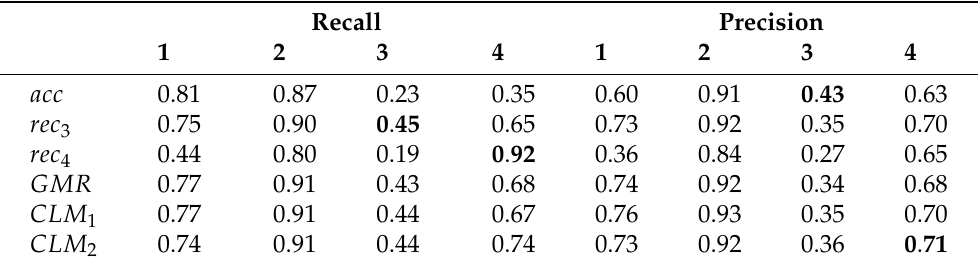
Table 7. Recall and precision over the test set for each validation metric and for each class state. The best values for class states 3 and 4 are highlighted in